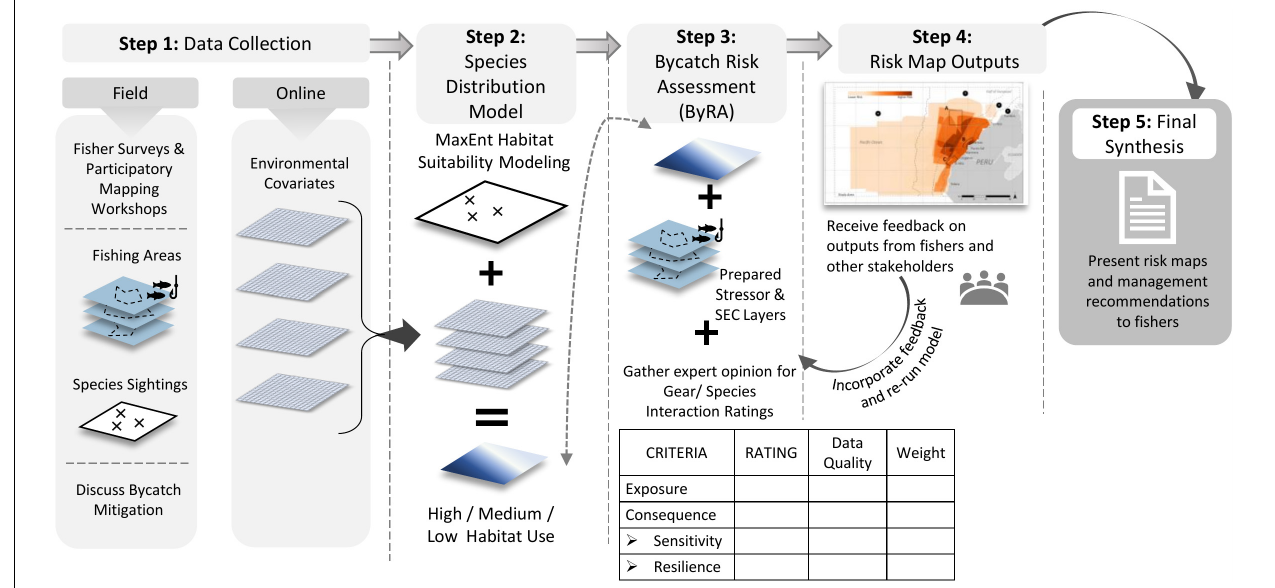
FIGURE 1 | Conceptual model of the Bycatch Risk Assessment (ByRA) process used in our case study. ByRA begins with data collection in Step 1 and ends with the Final Synthesis of the risk maps and recommended management strategies. Each step depicts the basic spatial layers necessary for completing the step and how the output of one process flows into the next. Fisher participation was prevalent in Step 1, 4, and 5 for data collection, data review, and output presentation and discussions. See Verutes et al. (2020) for further description on ByRA model including how ratings scores are assembled, and risk plots are determined.